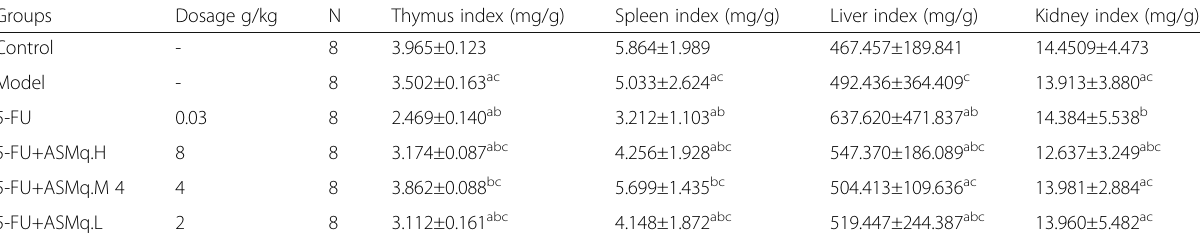
Table 2 The effects of 5-FU combined with Abnormal Savda Munziq on the viscera index in mice bearing U27 cell-induced tumors ( x ± s ) Groups